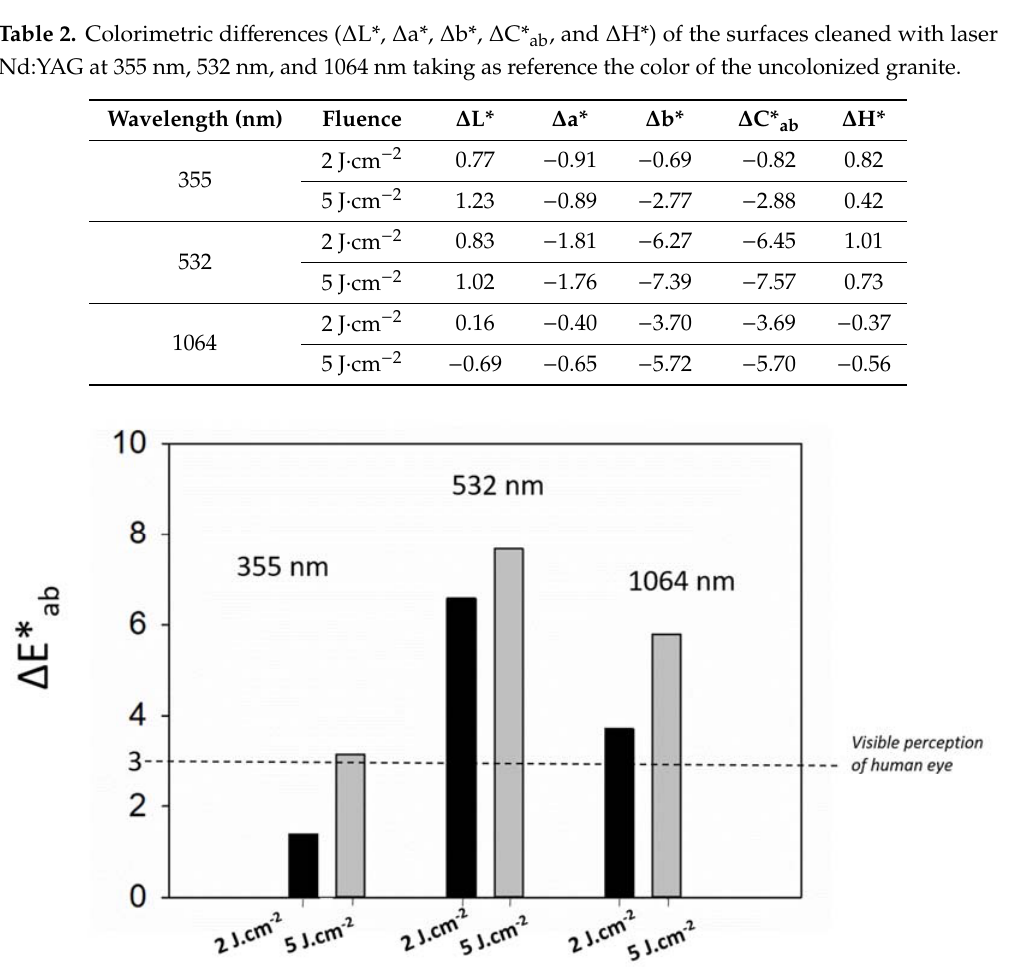
Figure 3. Global color changes ( Δ E* ab , CIELAB units) of the granite cleaned of the SAB by means of an Nd:YAG at different wavelengths: 355 nm, 532 nm and 1064 nm with two different fluences: 2 J ∙ cm − 2 and 5 J ∙ cm − 2 . Δ E* ab was computed taking as reference the reference uncolonized granite. Therefore, the lower the Δ E* ab , the more similar to the reference the surface.